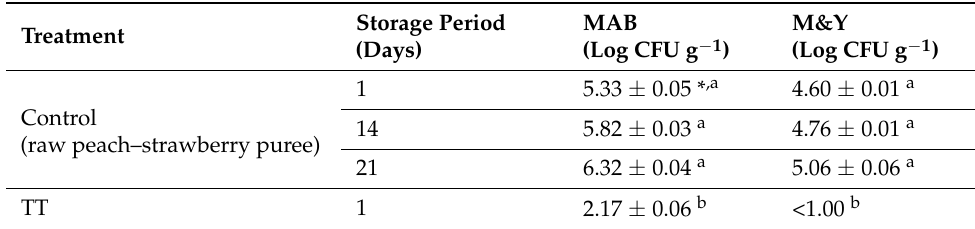
Table 1. Microbial counts changes for TT, HPP and HPMT peach–strawberry purees during 21 days of refrigerated